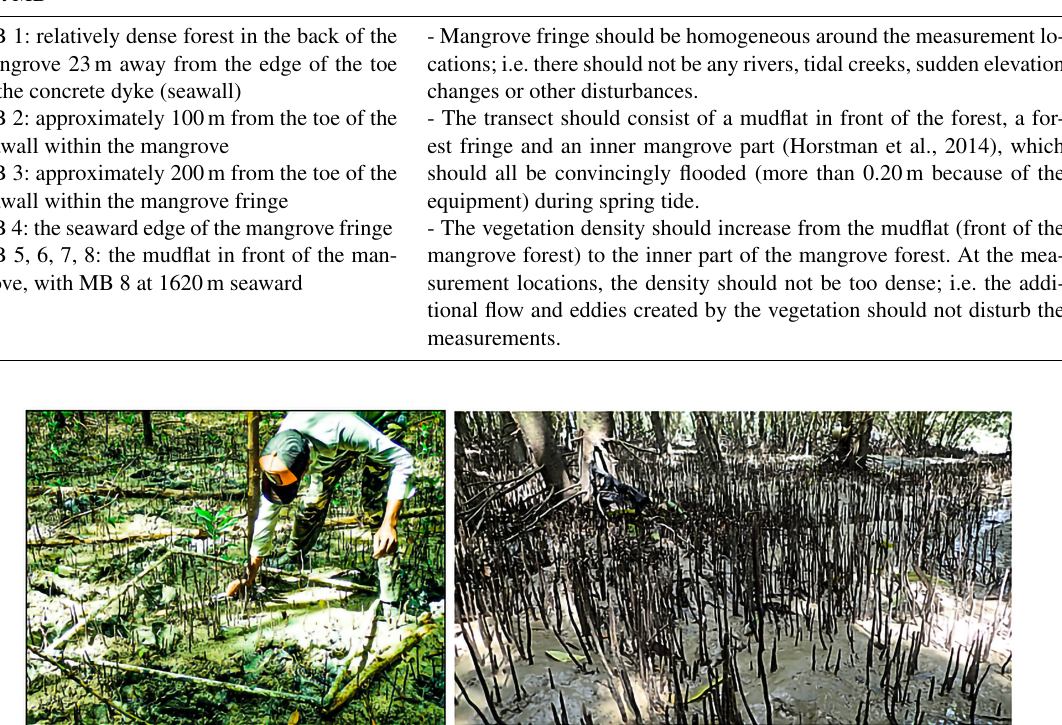
Table 2. Criteria considered for the establishment of field stations and the description of all station points outlined in Fig. 2a. Description of measurement stations along tran- Criteria for the selection process sect MB